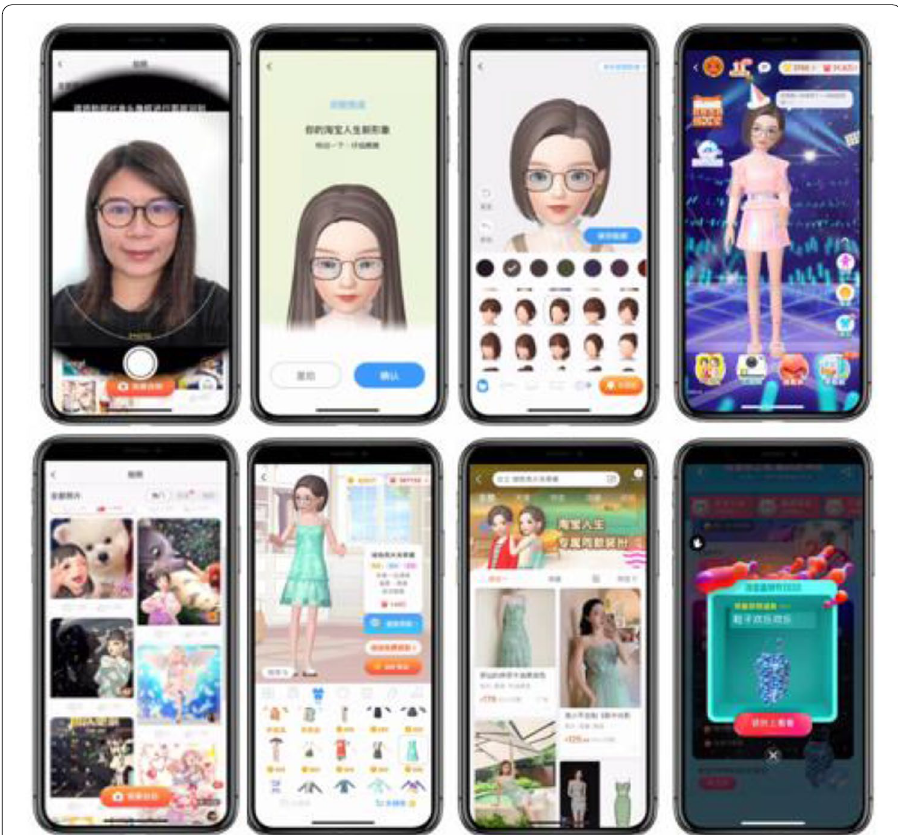
Fig. 2 Stimuli: Taobao life, a 3D avatar‑based and game‑featured virtual world on the Taobao